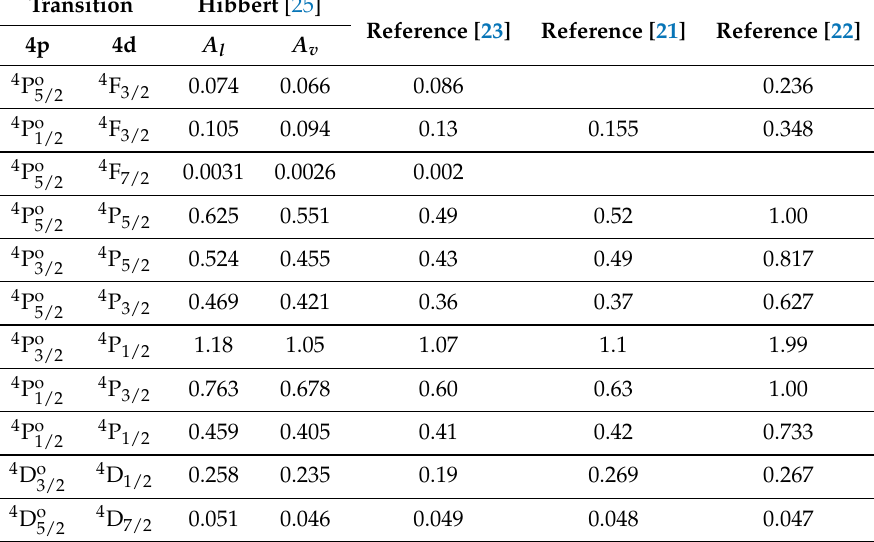
Table 3. A-values (10 8 s − 1 ) for 4p–4d transitions in Ar